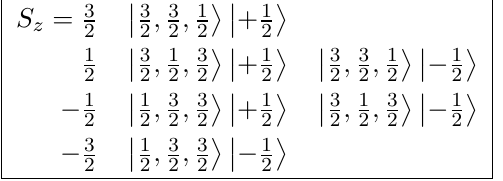
Table 6 . The states of L (3 = 2 ; 3 = 2 ; 1 = 2) (cid:10) V (1 =